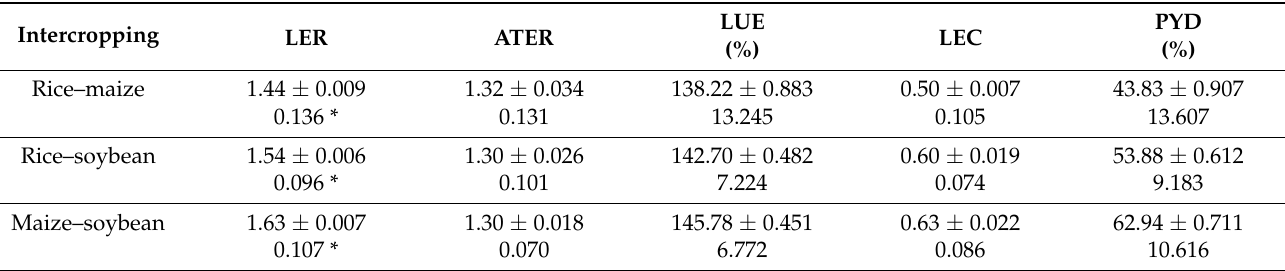
Table 4. Land equivalent ratio (LER), area time equivalent ratio (ATER), land use efficiency (LUE), land equivalent coefficient (LEC), and percentage yield difference (PYD) for different IPs in compari- son with MPs on rainfed areas of western Indonesia with a wet